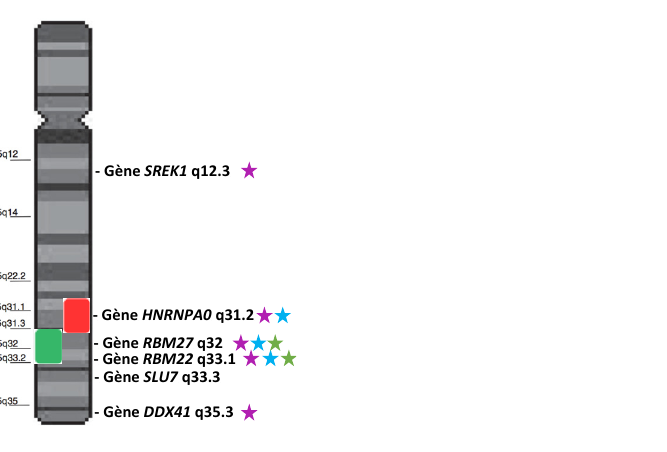
Figure 1. Schematic representation of chromosome 5 and two characteristic CDRs: the 5q ‐ CDR (green box) and the higher ‐ risk CDR (red box). Genes annotated as “splicing genes” are represented in front of their locus. Purple stars indicate the genes involved/mutated/dysregulated in MDS or hematopoiesis. Blue stars indicate the genes located in the most frequently deleted region. Green stars indicate the most dysregulated genes in the 5q ‐ syndrome.